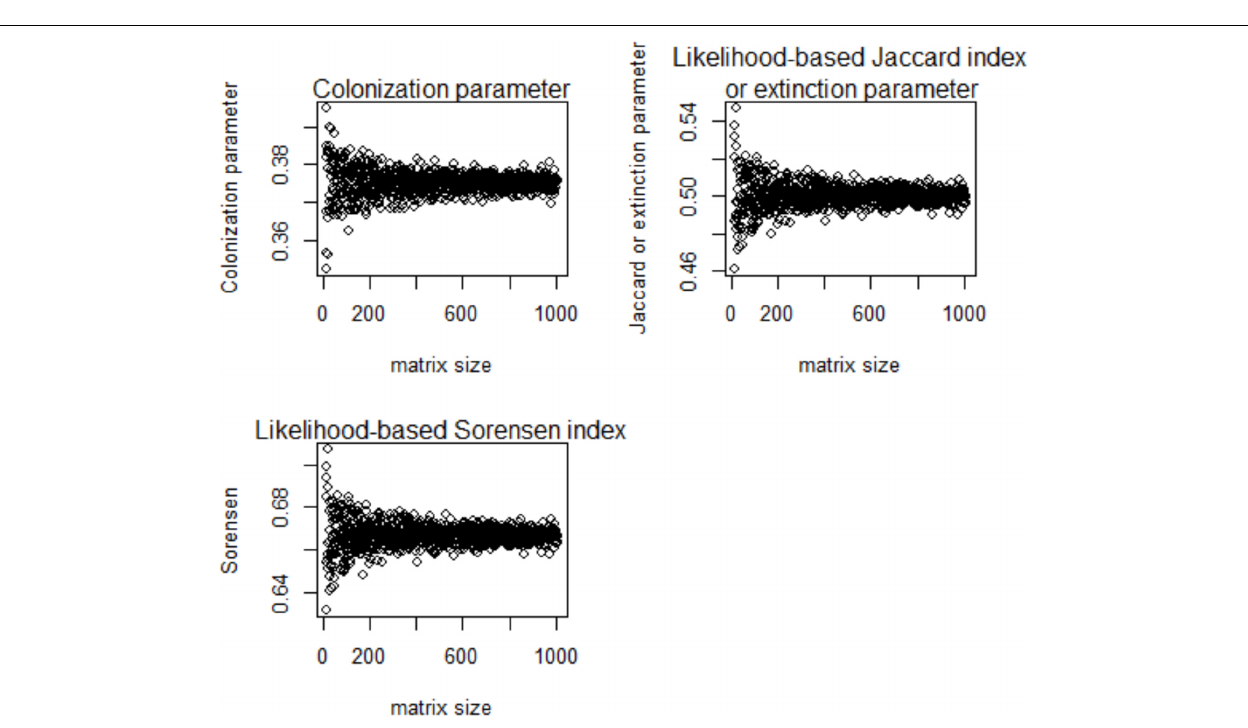
Frontiers in Ecology and Evolution | www.frontiersin.org